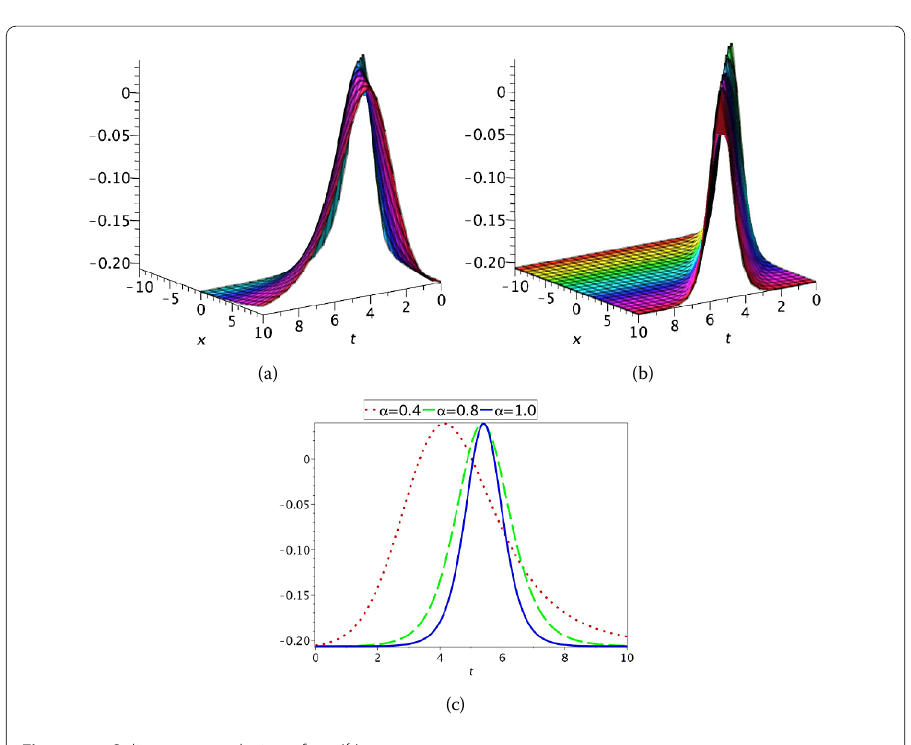
Figure 11 Solitary wave solution of u 2,4 ( ξ